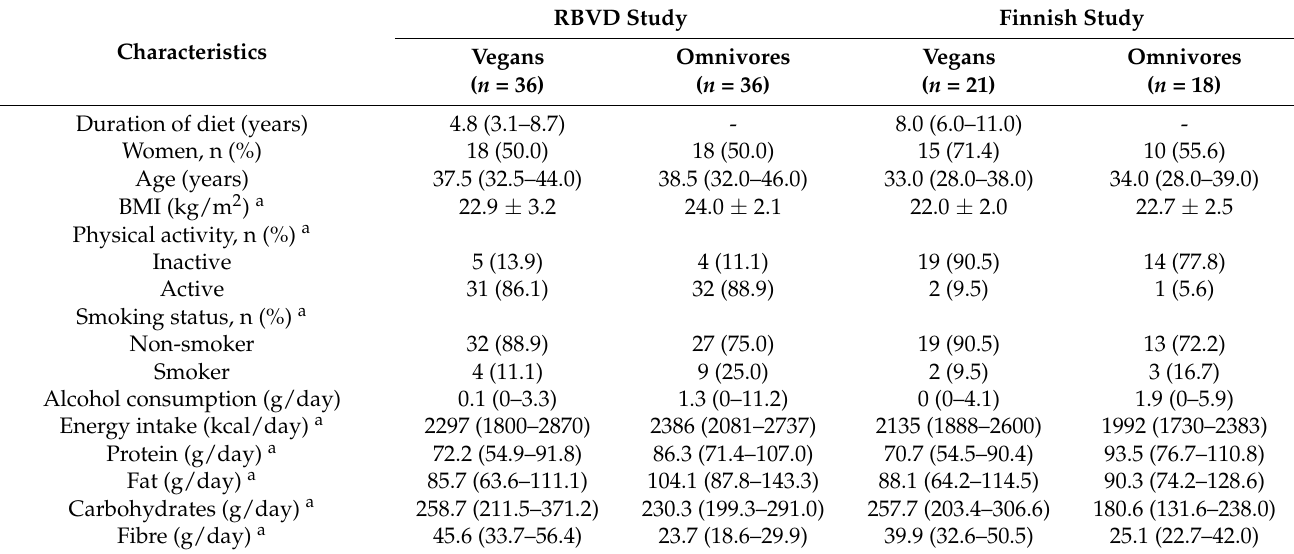
Table 1. Characteristics of the RBDV and the Finnish study stratified by dietary